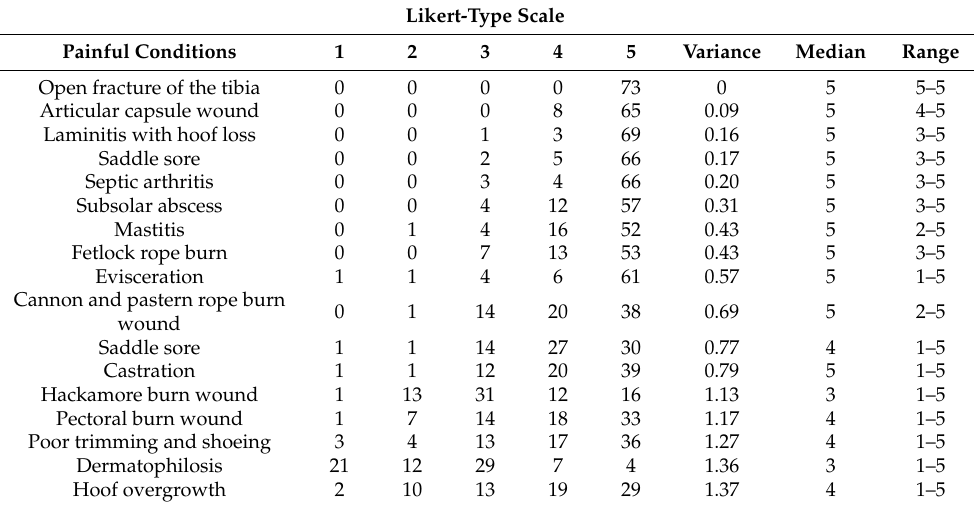
Table 3. Distribution of the soldiers ( n = 73) according to pain score (1 = “no pain; 5 = maximum possible pain) assigned to each of the 17 photographs of painful conditions presented to them. Variance, median and range are